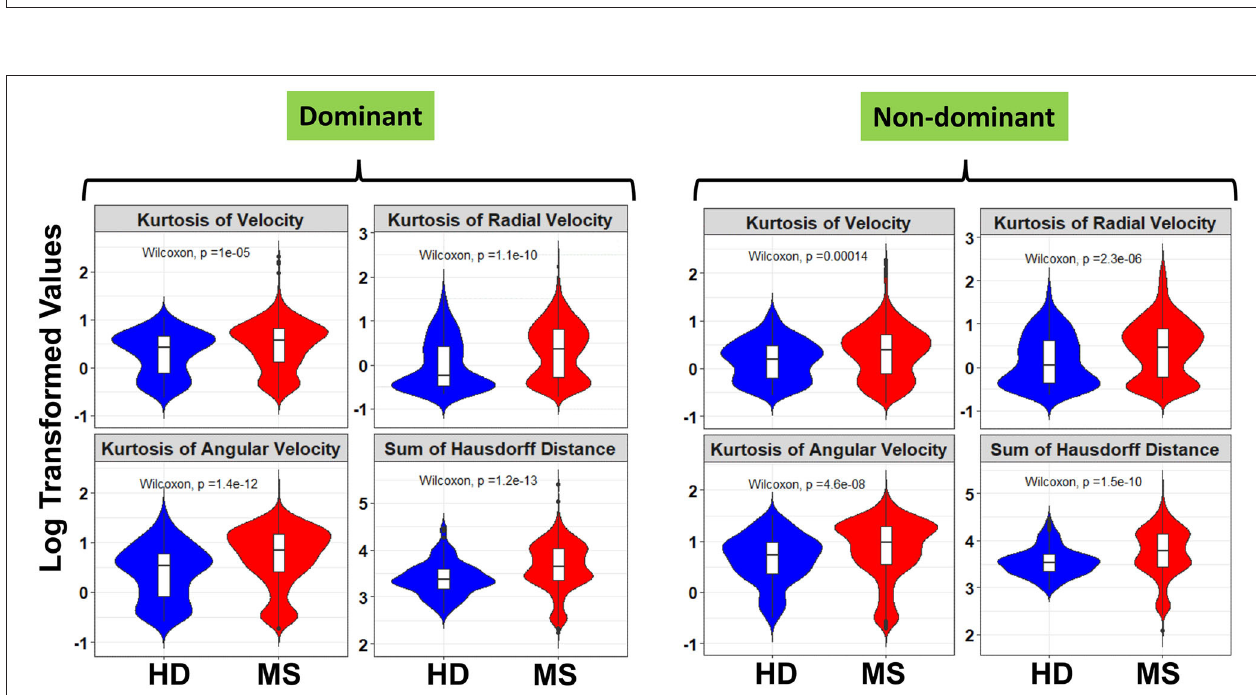
FIGURE 6 | Violin and boxplot of the selected spiral-derived features with FC > 2 and ICC > 0.5 with respect to healthy donors and patients with MS at the difficulty level 2. The blue color indicates the healthy donors while red shows the patients with MS. There were multiple tests per subject in the HD and MS group. Values are shown using a bi-symmetric log transformation for both the dominant and non-dominant hand (The p indicates the p -value of the unpaired Two-Samples Wilcoxon test for the mean comparison of HD and MS groups).